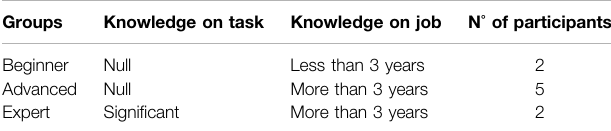
TABLE 2 | Repartition of workers according to their knowledge on the task and the